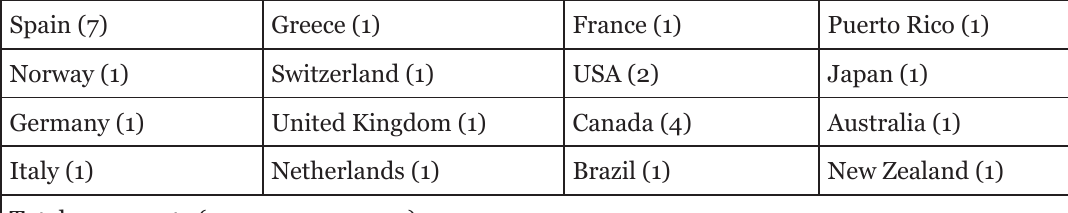
Geographical Distribution of the Participating Experts Spain (7)